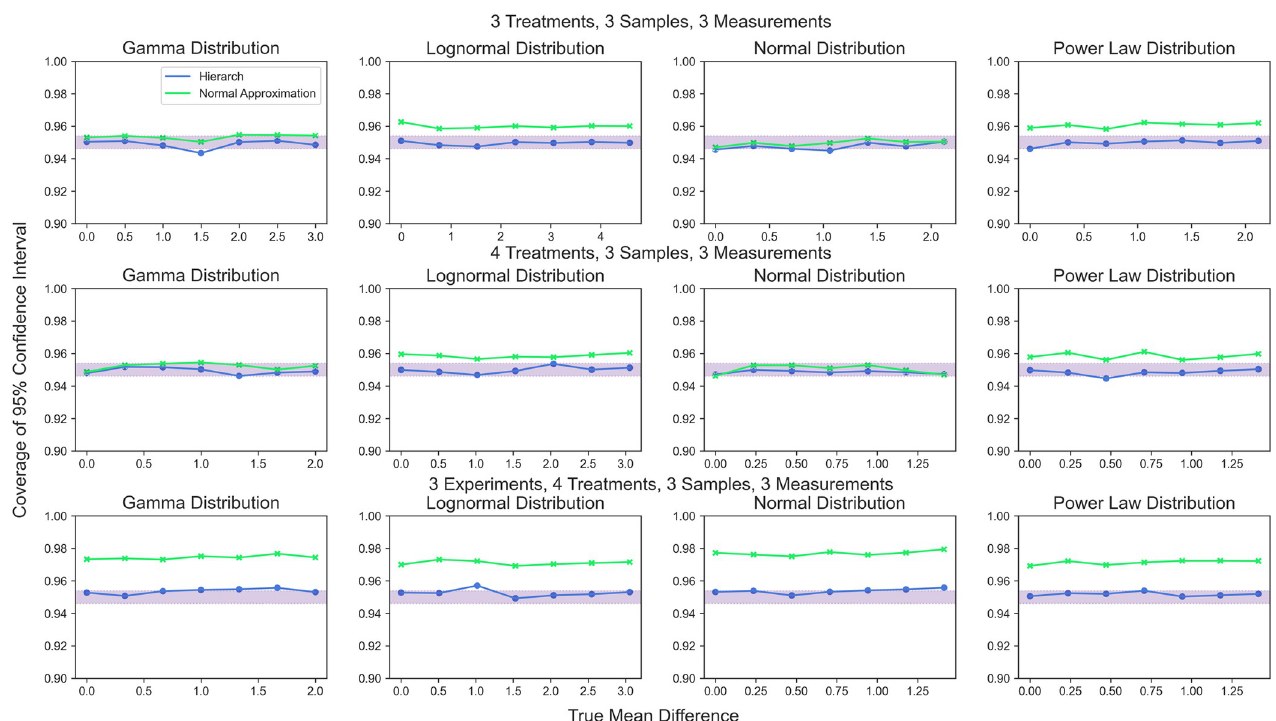
Fig 13. Coverage probability of 95% confidence intervals generated by test inversion. Shaded area represents the 95% binomial confidence interval around a 95% coverage probability.